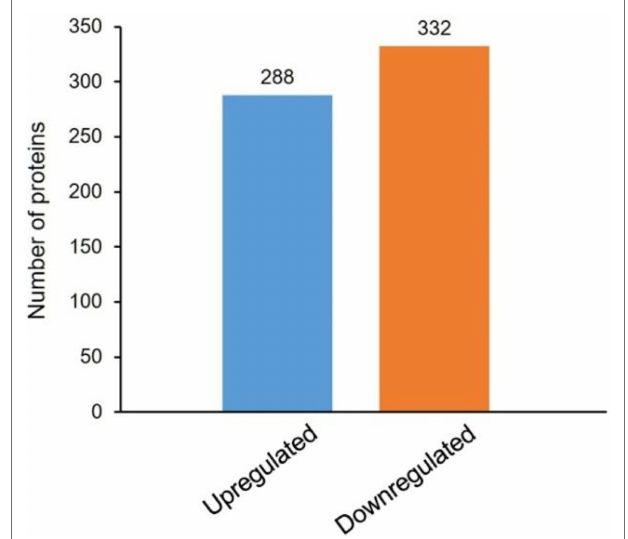
FIGURE 2 | Differentially expressed proteins of ∆ stk1 compared to the PAO1 strain. The red bar represents the number of upregulated proteins and the blue bar represents the number of downregulated